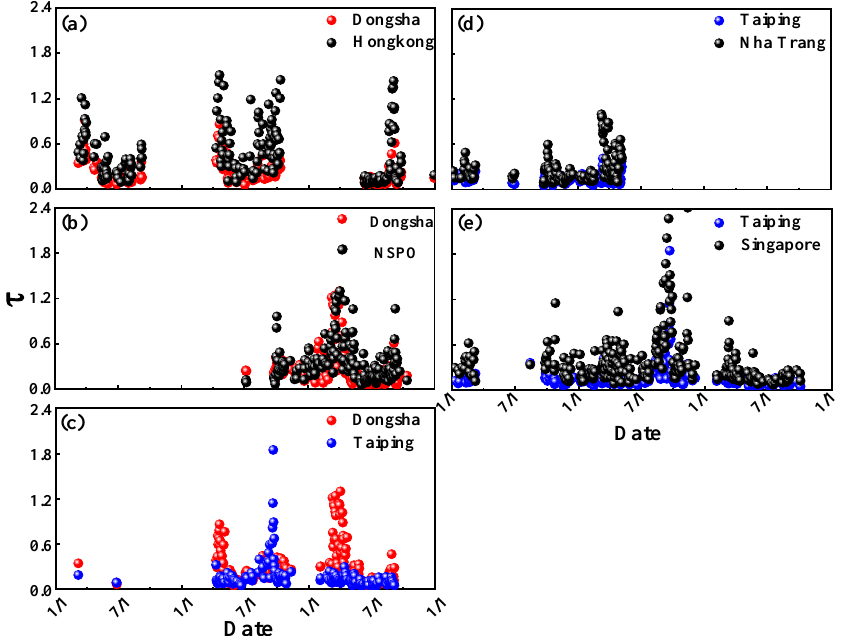
Figure 13. Comparisons of τ (500 nm): ( a ) Dongsha Island and NSPO, ( b ) Dongsha Island and Hong Kong, ( c ) Dongsha Island and Taiping Island, ( d ) Taiping Island and Nha Trang, and ( e ) Taiping Island and Singapore. Table 3. Mean value of τ, α (440 – 870 nm), τ F (500 nm), τ C (500 nm) and FMF obtained over Dongsha (DS), NSPO (NS), Hong Kong (HK), Taiping (TP), Nha Trang (NT) and Singapore (SP). Here, the